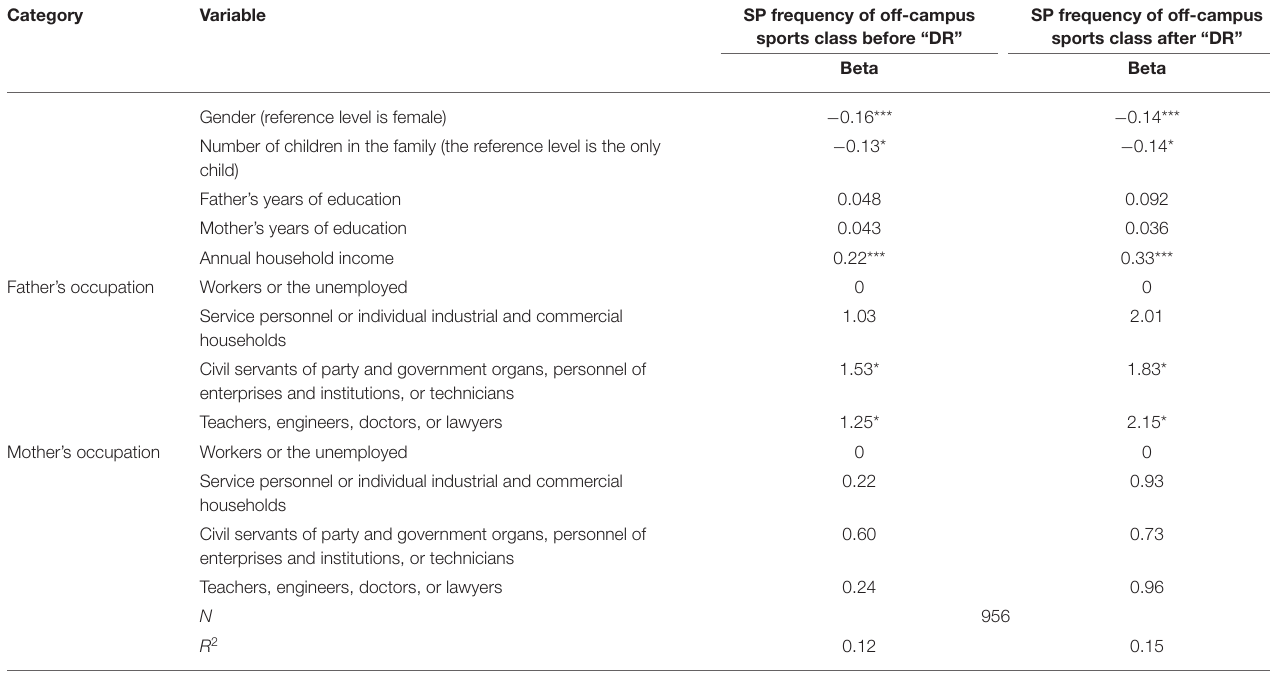
TABLE 4 | Multiple regression analysis (MRA) results of off-campus class SP frequency. Category